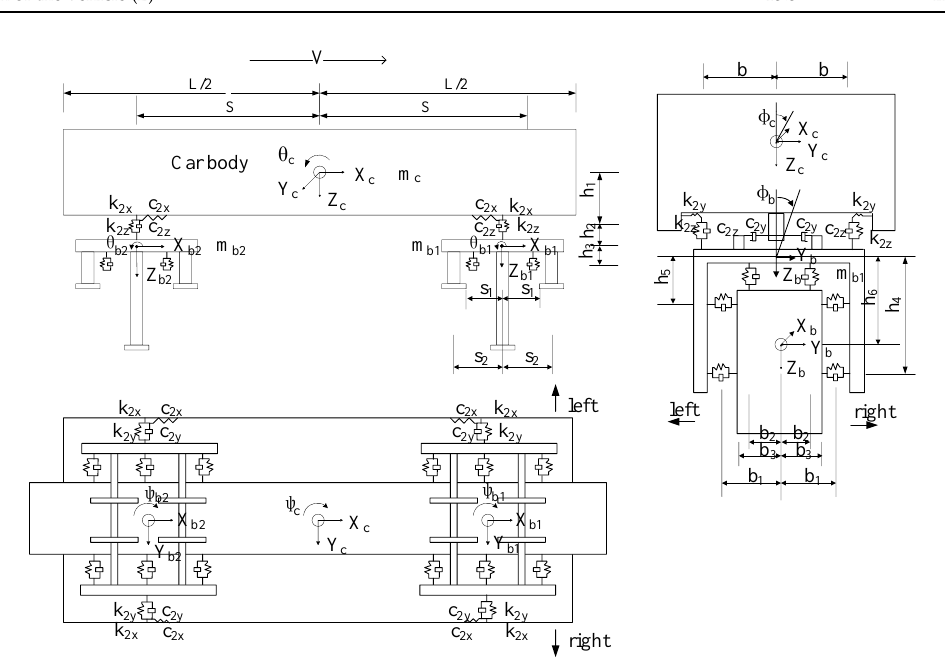
Figure 3. The idealized monorail train with 15 DOFs.